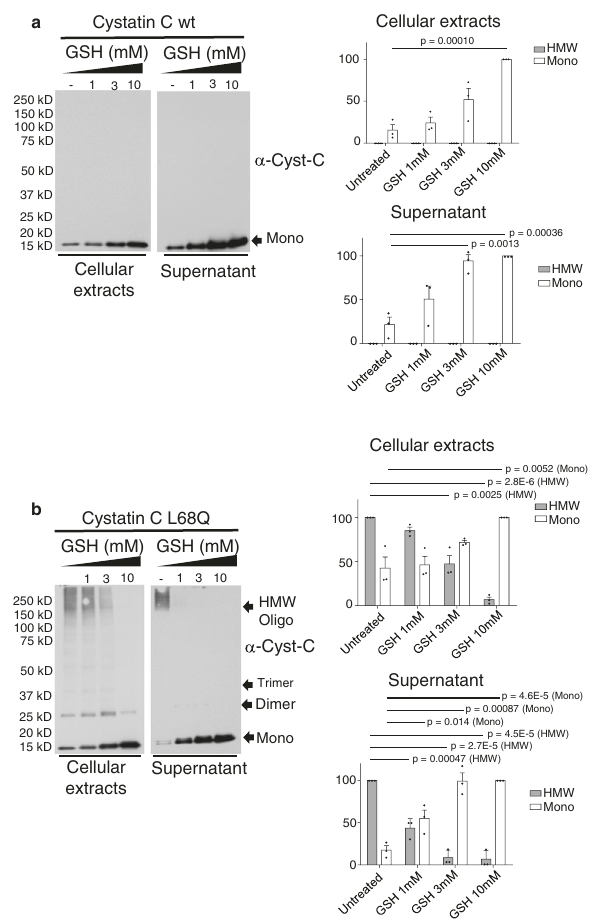
Fig. 1 Incubation with glutathione impairs cystatin C di-/oligomerization in cellular extracts and supernatants. Supernatants and cellular extracts from hCC WT- ( a ) or L68Q-expressing ( b ) cells were incubated in the presence of glutathione (GSH) at the indicated concentrations for 1 h at 37 °C. Samples were mixed with 2% SDS without reducing agents prior to electrophoresis, and protein levels were detected by Western blot for cystatin C, and amounts of monomeric hCC (Mono) or high-molecular- weight hCC species (HMW) were quantitated ( N = 3 independent experiments; one-tailed student t test; indicated p values were less than 0.05, without correction for multiple testing, with respect to untreated). In blots and graphs, bars are means, error bars represent standard